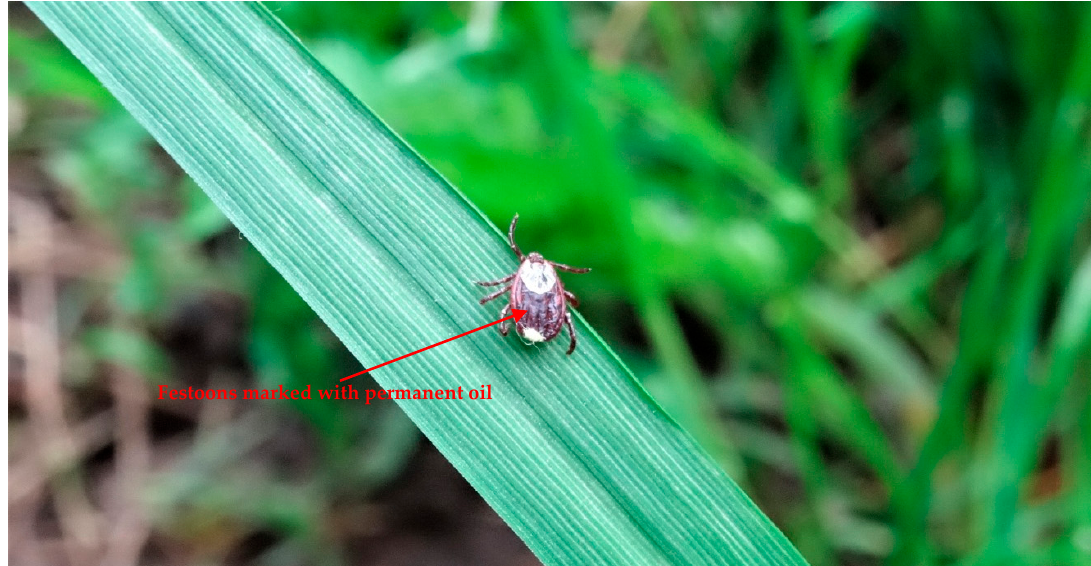
Figure 1. Adult Dermacentor reticulatus female in natural condition that previously has been marked with a permanent oil marker (yellow) on the festoons.